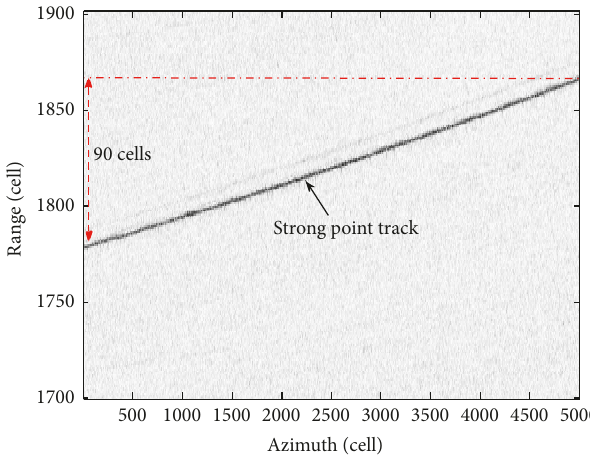
Figure 6: CF-RCMC result (monostatic SAR). The horizontal line indicates that the RCM has been successfully corrected.